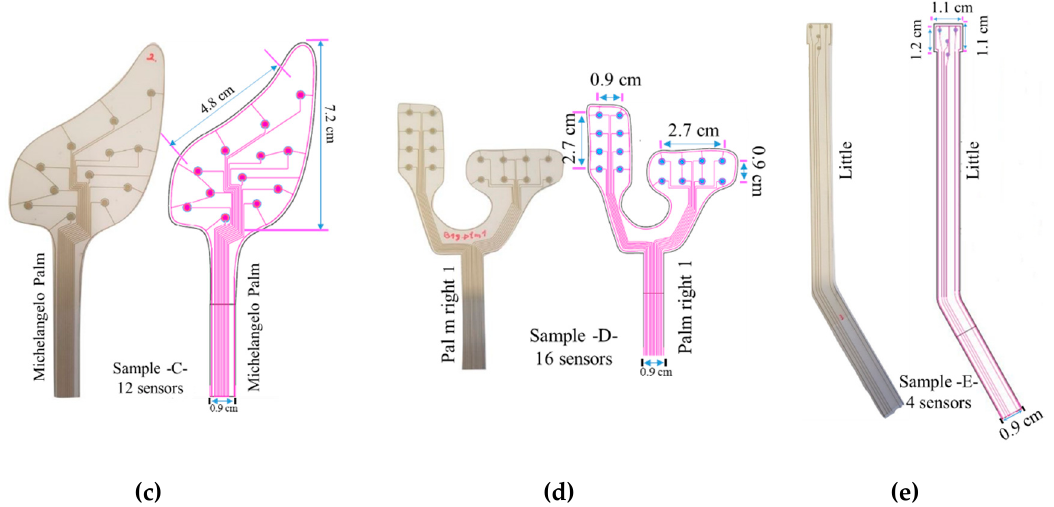
Figure 3. Design of different sensing patches. ( a ) Sample A: Palm right 2 - 4 × 2 array = 8 taxels, Taxel diameter = 2 mm, center-to-center pitch = 1 cm, total sensing area = 2.1 × 1.1 cm 2 . ( b ) Sample B: Palm left 2 − 4 × 2 array = 8 taxels, Taxel diameter = 2 mm, pitch = 1.1 cm, total sensing area = 2.1 × 1.1 cm 2 . ( c ) Sample C: Michelangelo palm − 12 taxels, taxel diameter = 2mm. ( d ) Sample D: Palm right 1 − two 4 × 2 arrays − 16 taxels, Taxel diameter = 2 mm, center-to-center pitch = 0.9 cm, total sensing area = 0.9 × 2.7 cm 2 . ( e ) Sample E: Michelangelo little - 4 taxels, taxel diameter = 1 mm, total sensing area: square side = 1.1